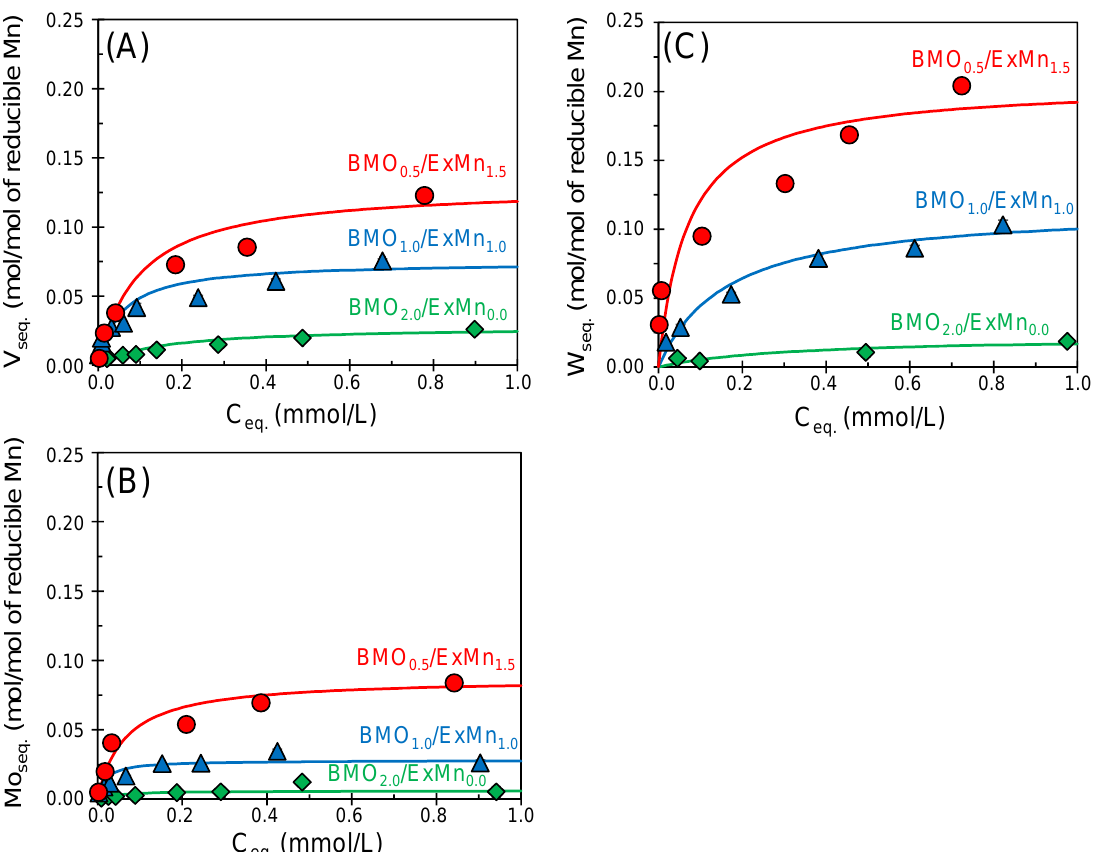
Figure 5. Apparent Langmuir isotherms of ( A ) V(V), ( B ) Mo(VI), and ( C ) W(VI) sequestration under the experimental conditions of BMO 2.0 /ExMn 0.0 , BMO 1.0 /ExMn 1.0 , and BMO 0.5 /ExMn 1.5 , respectively (See Table 1). The amounts of oxyanions sequestered (V seq. , Mo seq. , and W seq. ) were normalized relative to reducible Mn. The error bars represent the standard deviation (n = 3).